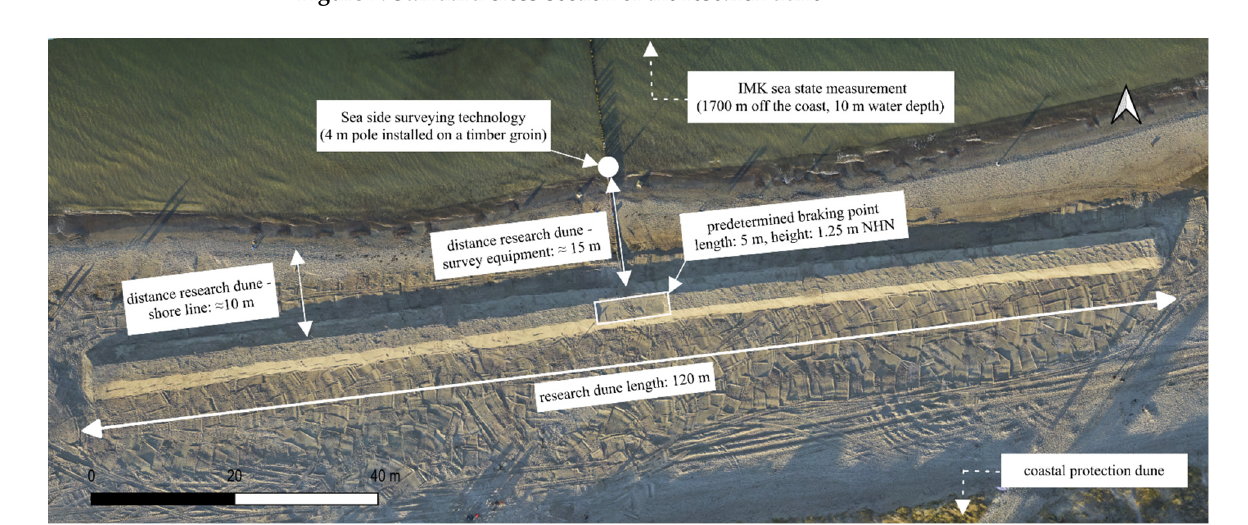
Figure 7. Standard cross-section of the research dune.